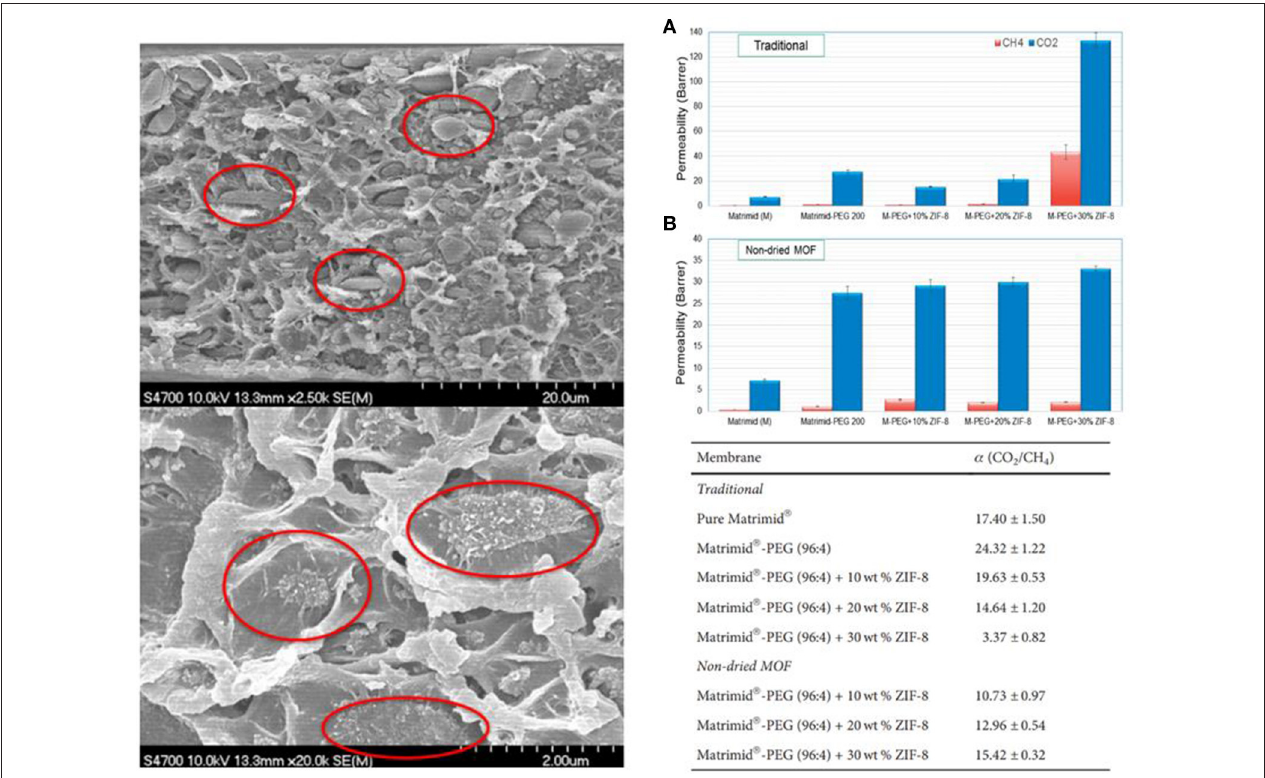
FIGURE 5 | Zeolitic imidazolate framework (ZIF)-8 agglomeration in tetracarboxylic dianhydride–diaminophenylindane (BTDA-DAPI) polyimide and its effect on gas separation (GS) performance. (A) Traditional method and (B) Non-dried MOF method. Adapted from Castro-Muñoz and Fila